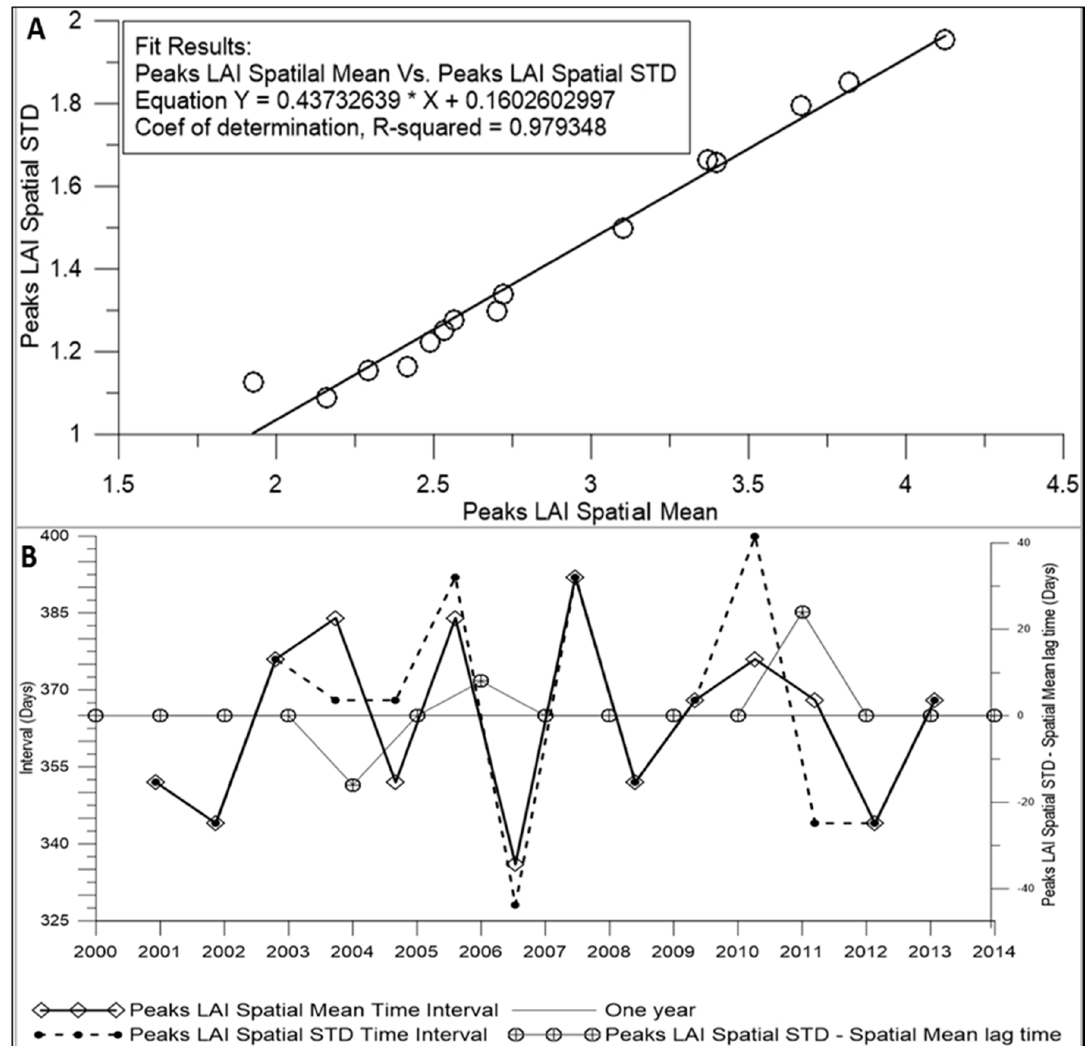
Figure 7. Peak LAI Spatial Mean and Peak LAI Spatial STD correlation ( A ). Peak LAI Spatial Mean and Peak LAI Spatial STD dynamic’s ( B ).